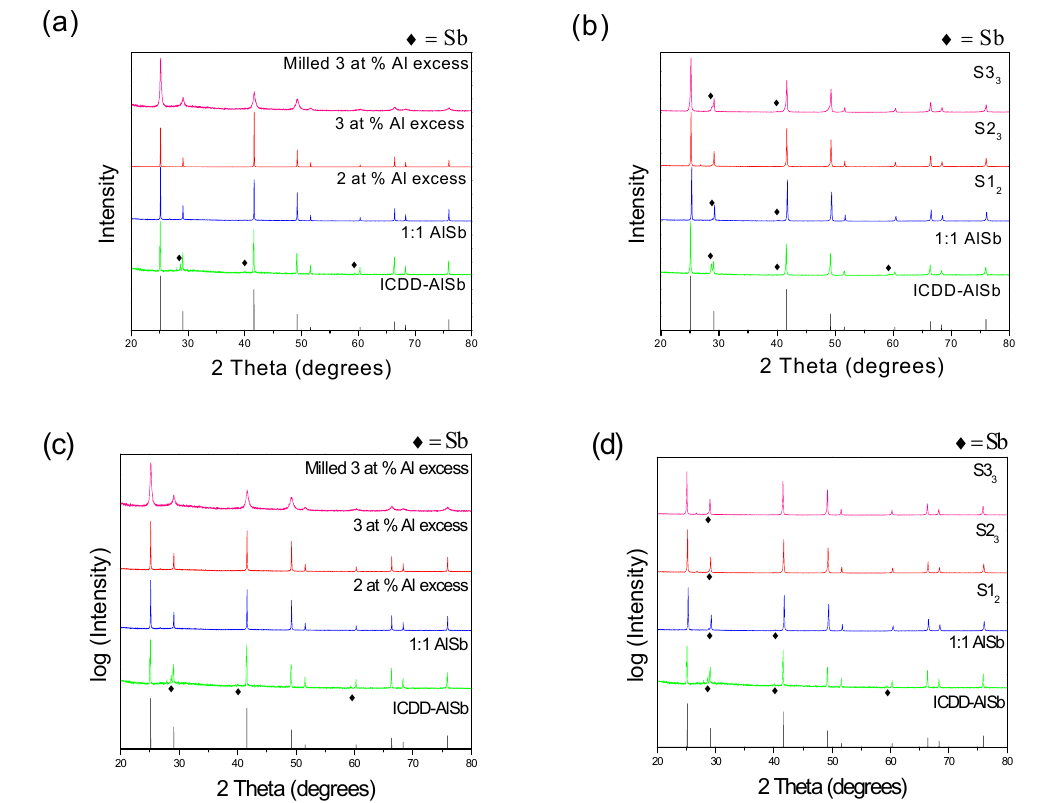
Figure 1. XRD data for ( a ) as casted and pulverized samples, ( b ) for VHPed samples, ( c ) as-casted samples in the logarithmic scale and ( d ) VHPed samples in the logarithmic scale. Appl. Sci. 2019 , 9 , x FOR PEER REVIEW